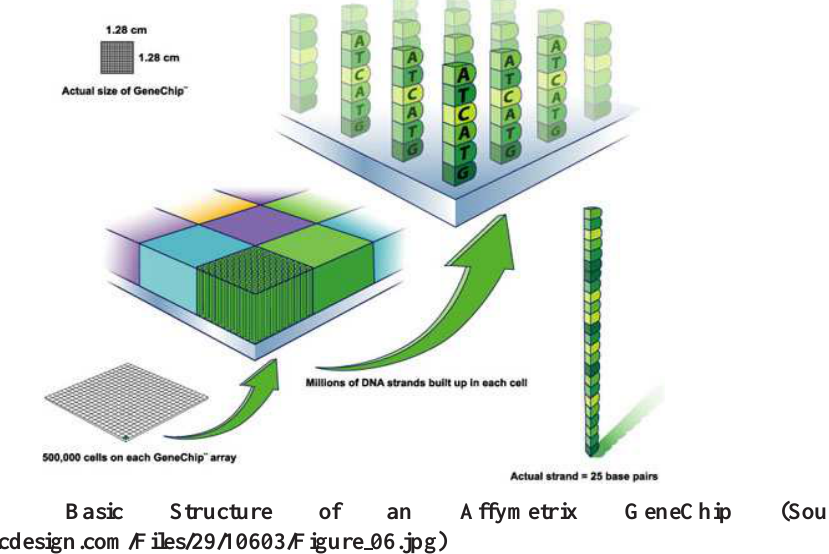
Figure 2: Basic Structure of an Affymetrix GeneChip